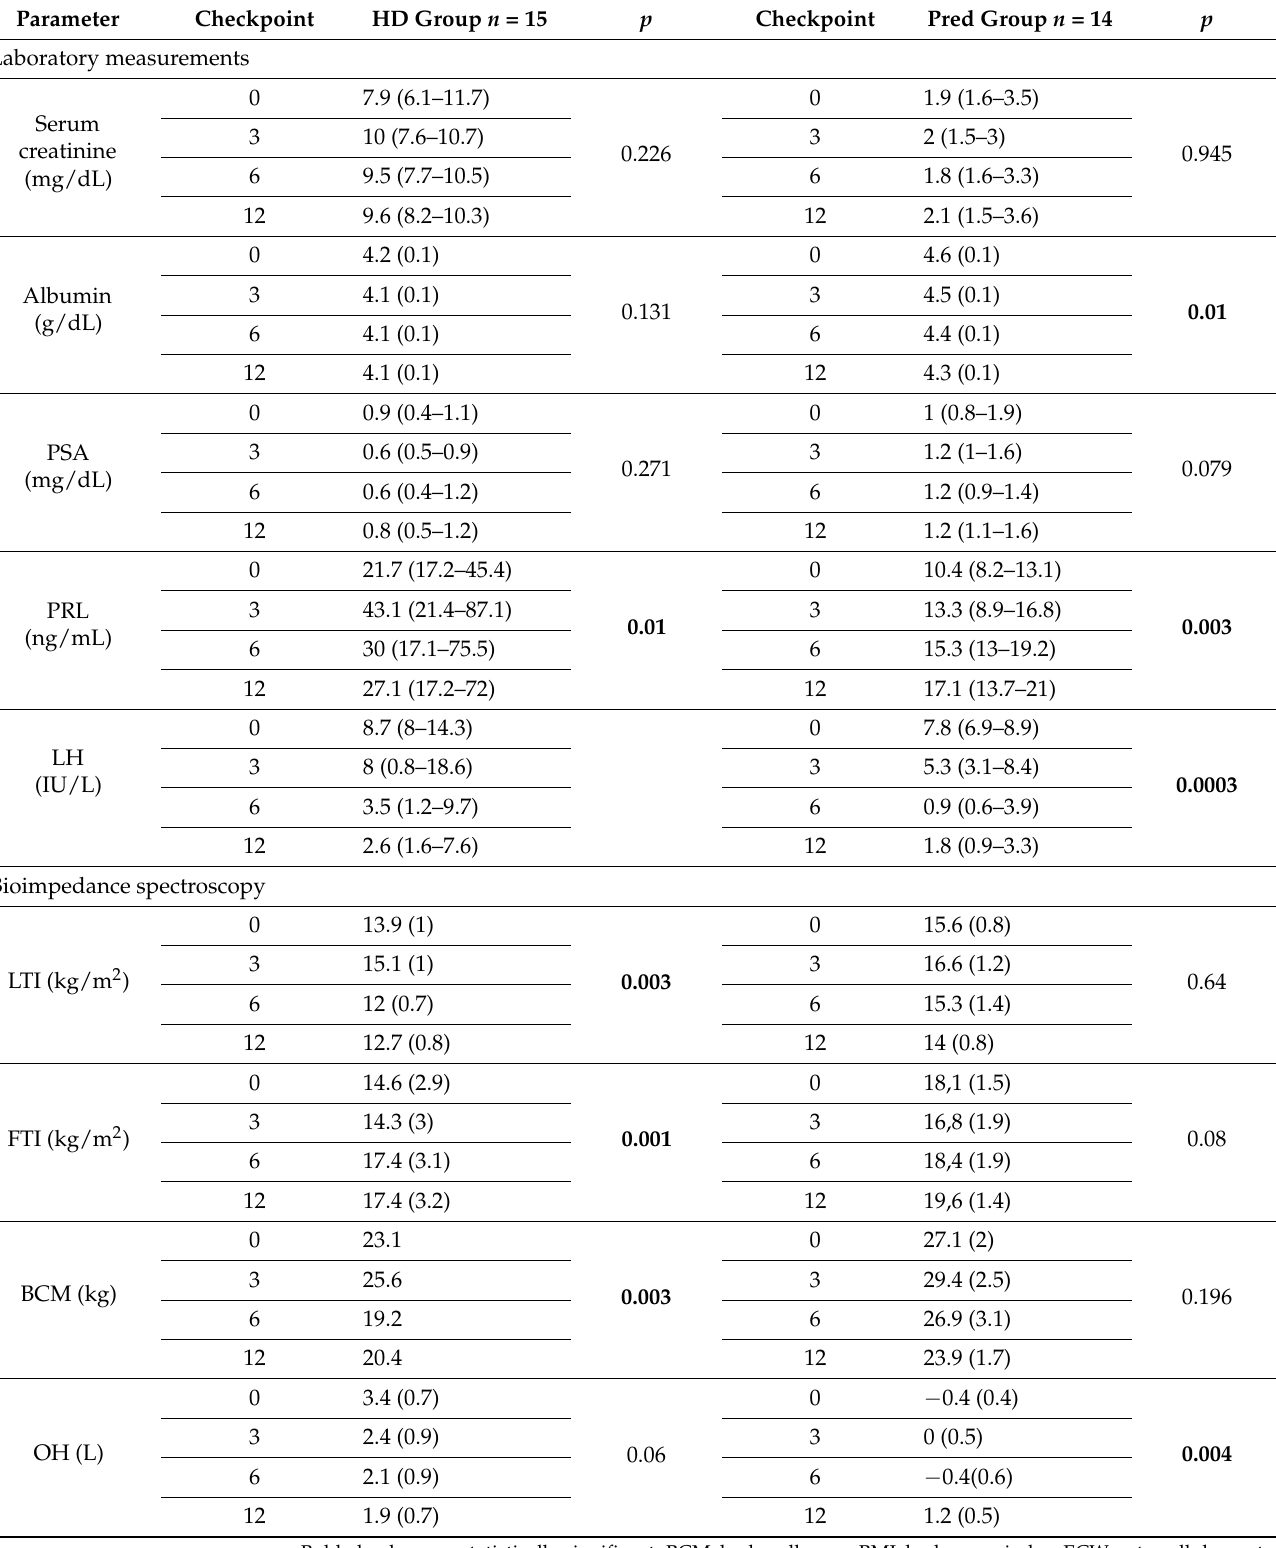
Table 2. Changes of the observed parameters during